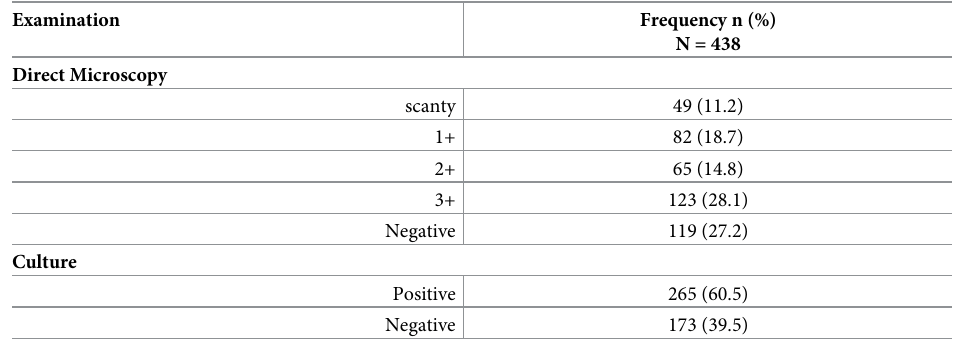
(Fig 8) [38]. Three of the four human M . bovis isolates had the same spoligotype patterns as the bovine isolates.